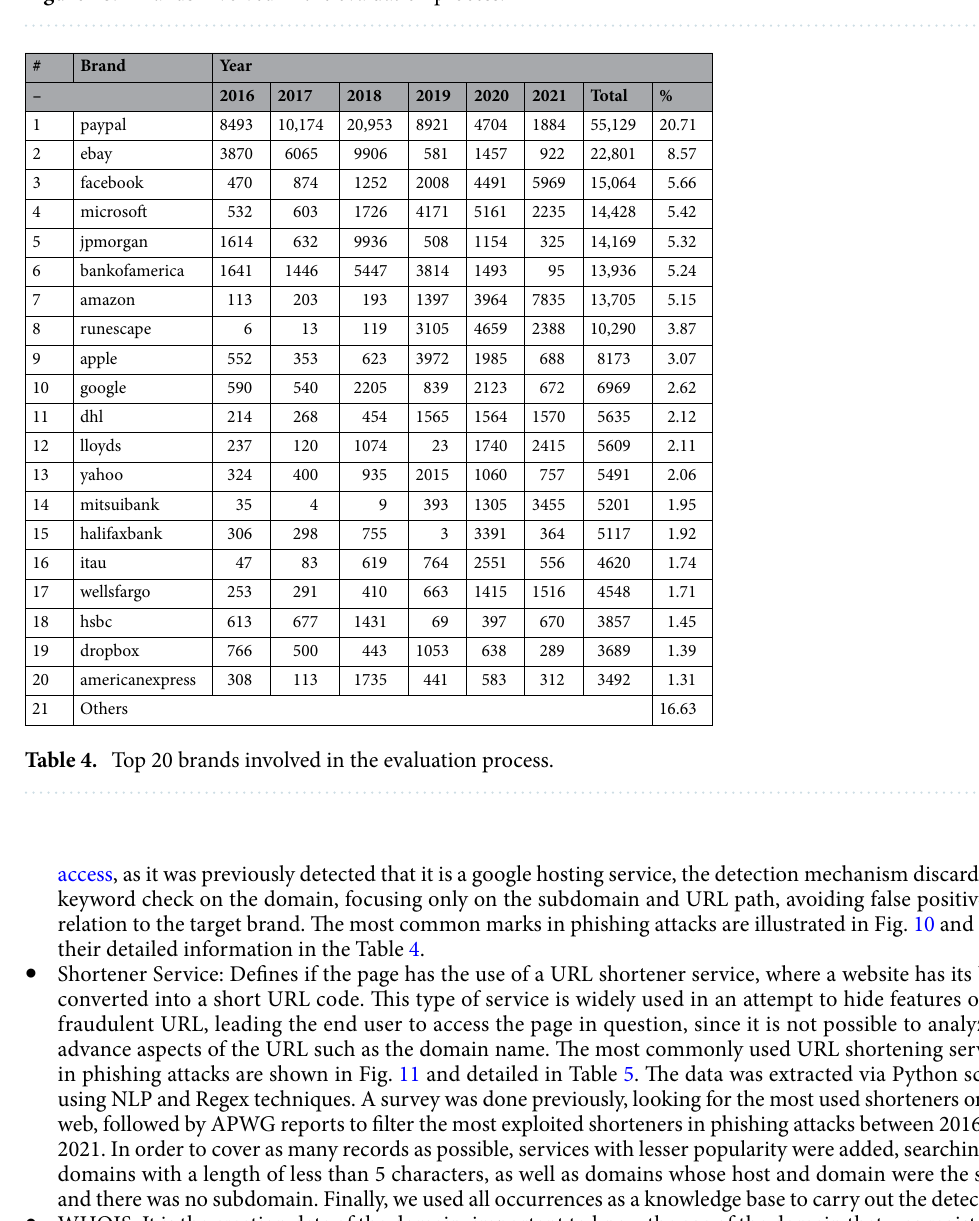
Figure 10. Brands involved in the evaluation process.